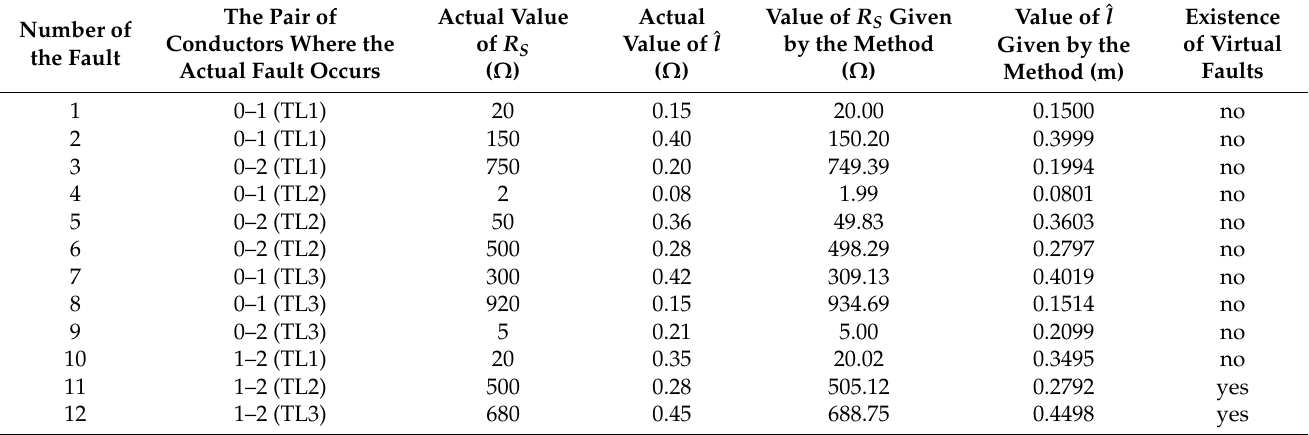
Table 3. Outcomes of the soft shorts diagnoses in the circuit of Figure